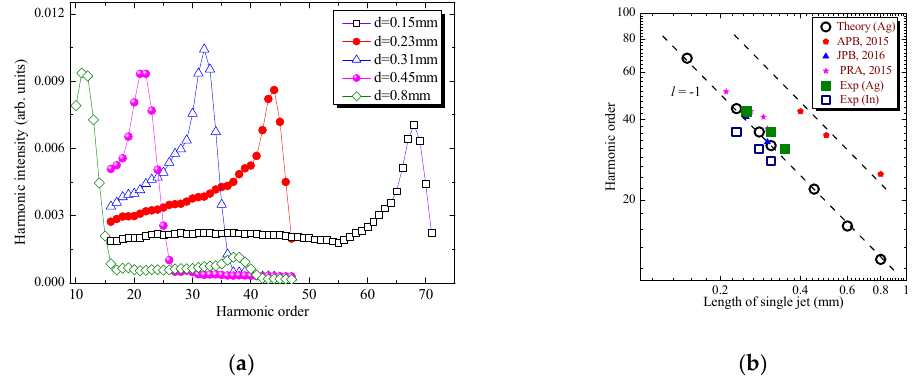
Figure 5. ( a ) Harmonic distribution from silver MJP in the case of propagation of two-color driving pulses (1310 nm + 655 nm) through the plasma of ~ 5 mm length containing the jets with the sizes ( d ) equal to 0.15 mm (black empty squares), 0.23 mm (red filled circles), 0.31 mm (blue empty triangles), 0.45 mm (pink filled spheres), and 0.8 mm (green empty rhombs). ( b ) Influence of the jet sizes on the order of maximally enhanced harmonic H qpm in the case of silver MJP. Black empty circles correspond to theoretical calculations and green filled squares correspond to experiment with Ag plasma. Triangles, stars and pentagons correspond to earlier reported data for silver plasma [40‒42]. Here we also show the experimental data for indium plasma (blue empty squares). The slopes of all dependences correspond to l = −1.